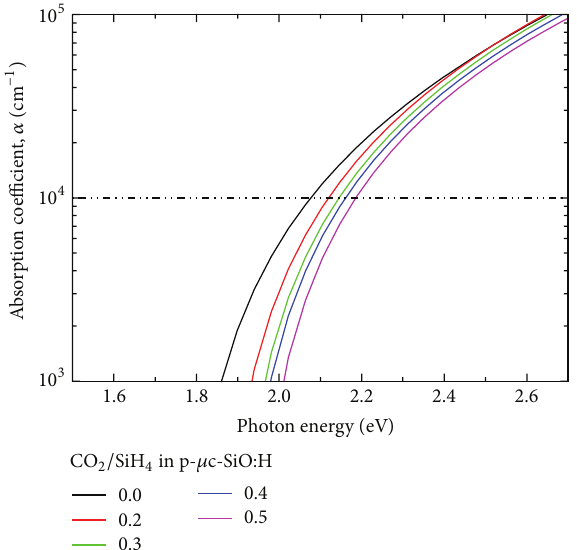
Figure 4: Absorption coefficient of p- 𝜇 c-SiO:H films with different CO 2 /SiH 4 ratios.